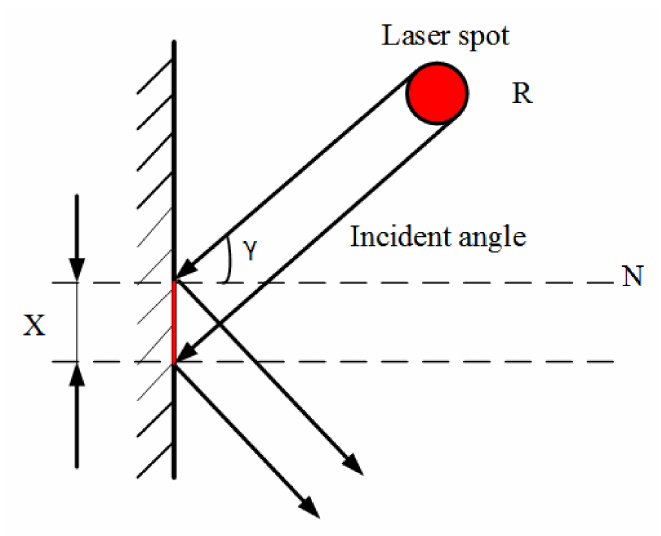
Figure 4. Influence of incident angle on long axis of light